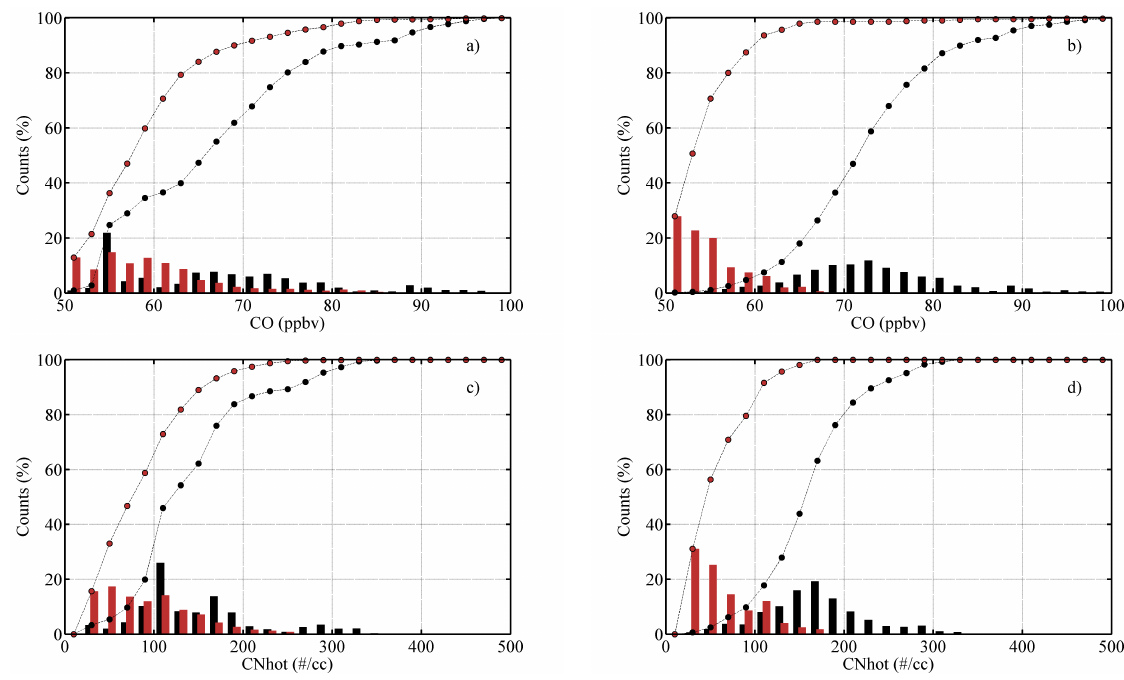
Fig. 4: Histograms and corresponding CDFs of measured CO (upper row) and CNhot (lower row) as obtained by classifying all back trajectories (data set T, column 1) and in-situ observations (data set M, column 2) into two distinct air mass groups. ITCZ and South American air masses are marked in red and black color, respectively. See section 4 for additional information.